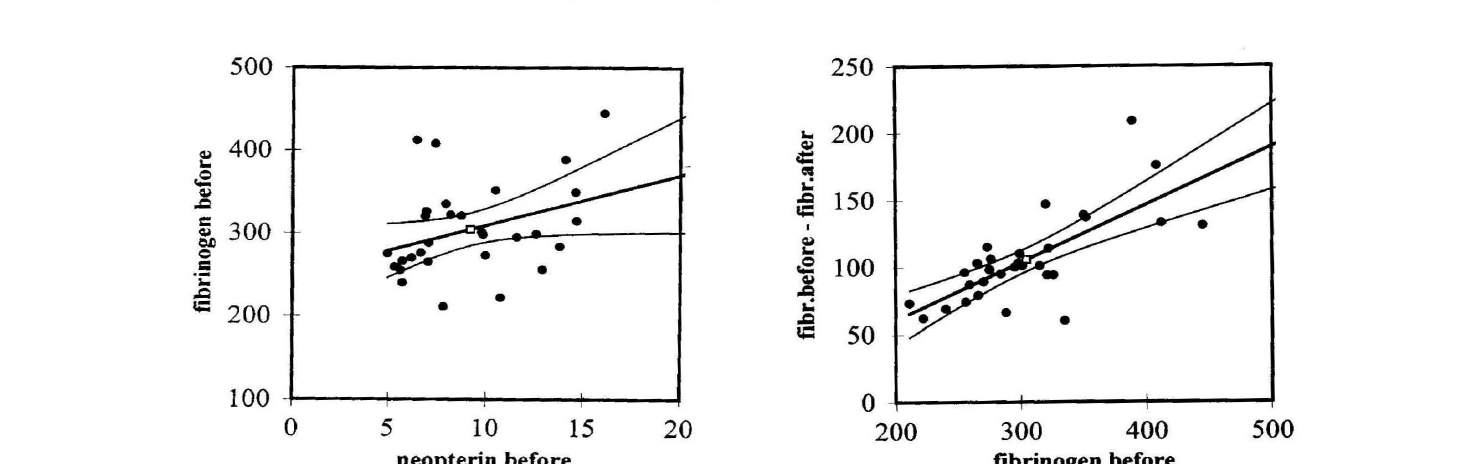
Figure 2. Linear correlation and regression analysis of fibrinogen before H .E.L.P versus fibrinogen difference before and after H.E.L.P. (bold straight line: regression line; hyperbolic Jines: 95 percent confidence limits of the regession line; r=+0.72, p < O.Ol)